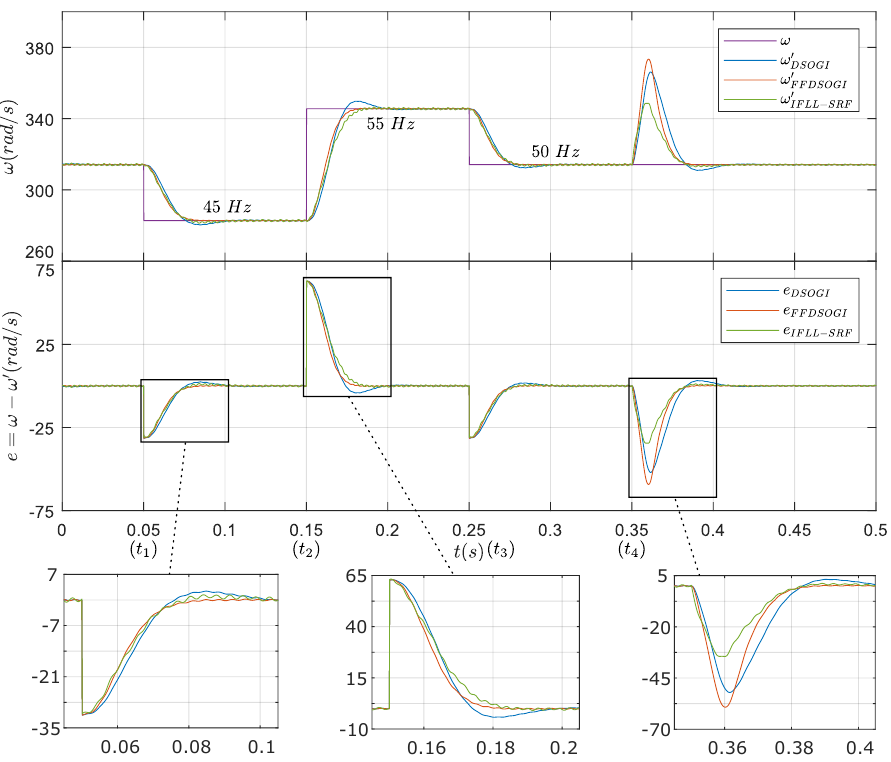
Figure 13. Estimated frequency errors for the different methods during test